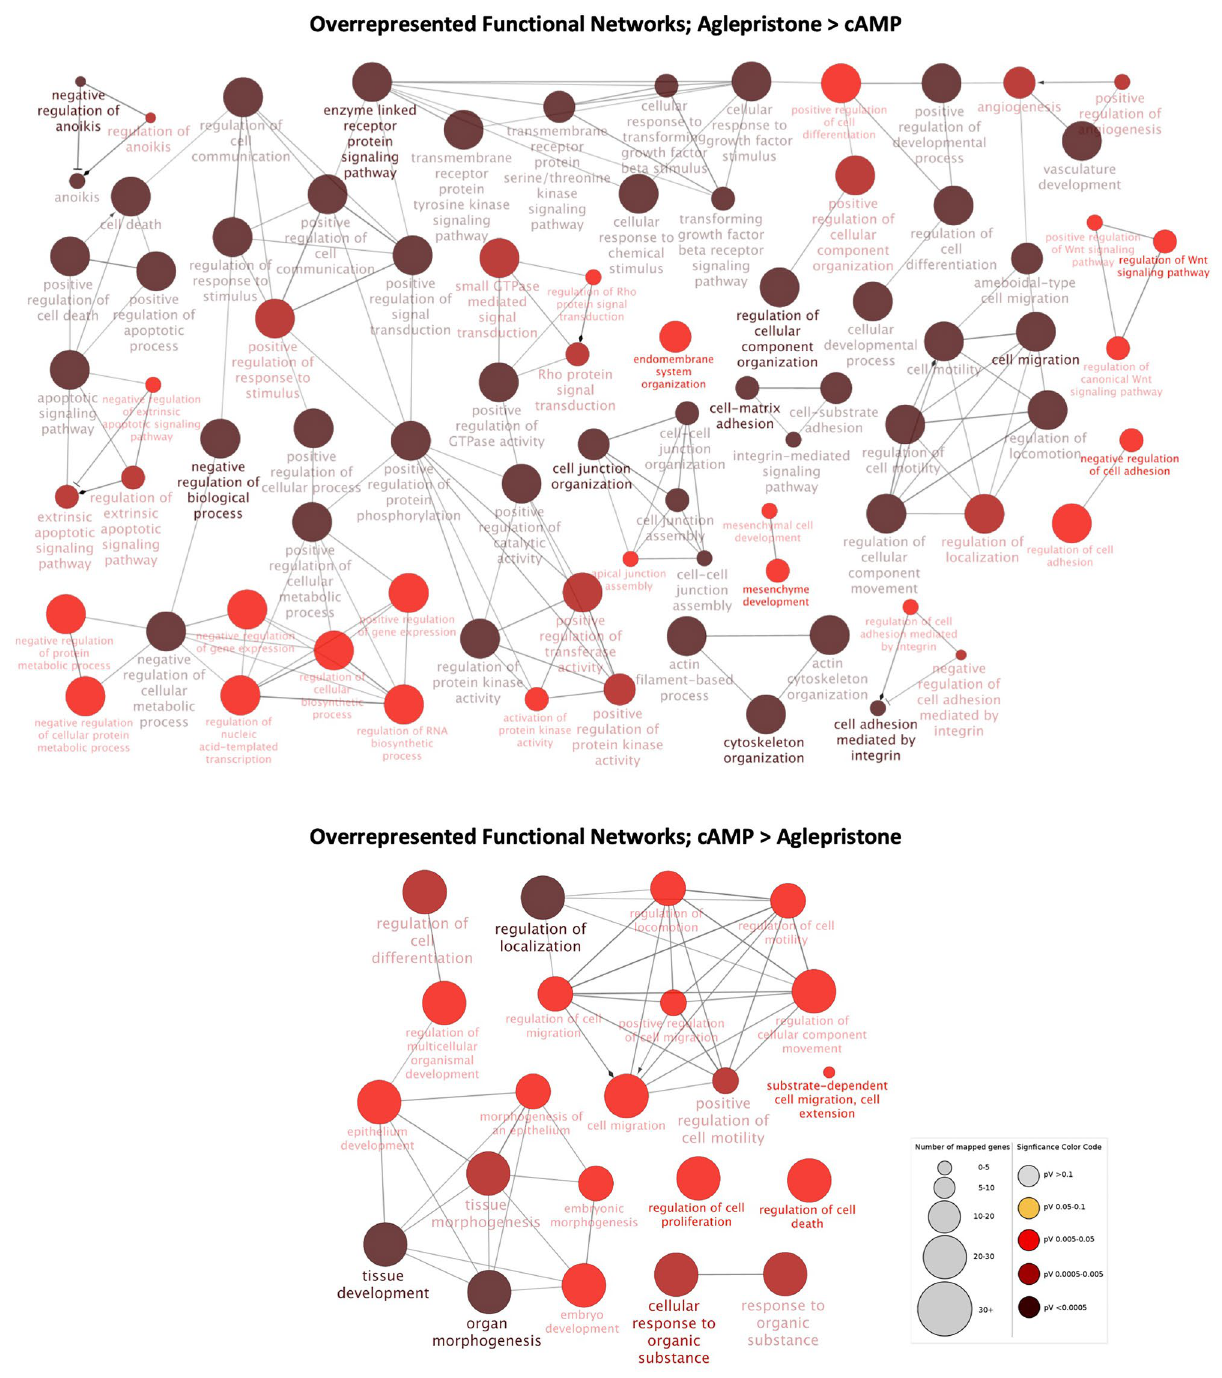
Figure 4. Functional networks overrepresented in the “aglepristone versus cAMP”, as determined by ClueGO (Cytoscape). Redundant and non-informative terms were removed, and the resulting networks were manually rearranged. The number of mapped genes for each term is represented by the node size, whereas the level of enhancement is denoted by node color (presented in the figure legend). Both upregulated (upper diagram) and downregulated (lower diagram) DEGs in decidualized DUS cells after aglepristone treatment were associated with the regulation of cell life cycle, cellular differentiation and migration. Functional networks solely overrepresented in upregulated DEGs were further associated with cell–cell communication and adhesion, cytoskeleton organization, anoikis and Wnt signaling, protein kinase activity, cell metabolism and